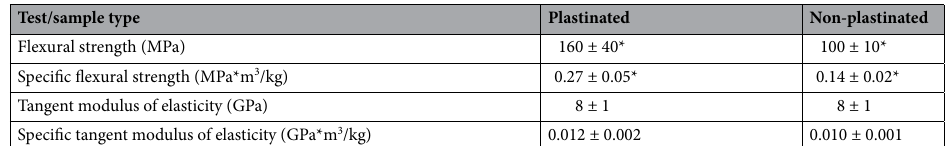
Test/sample type Plastinated Non-plastinated Flexural strength (MPa) Specific flexural strength (MPa*m 3 /kg) Tangent modulus of elasticity (GPa) Specific tangent modulus of elasticity (GPa*m 3 Table 2. Flexural strength and tangent modulus of elasticity results. *Significance level, P -value < 0.05 (One- way ANOVA).